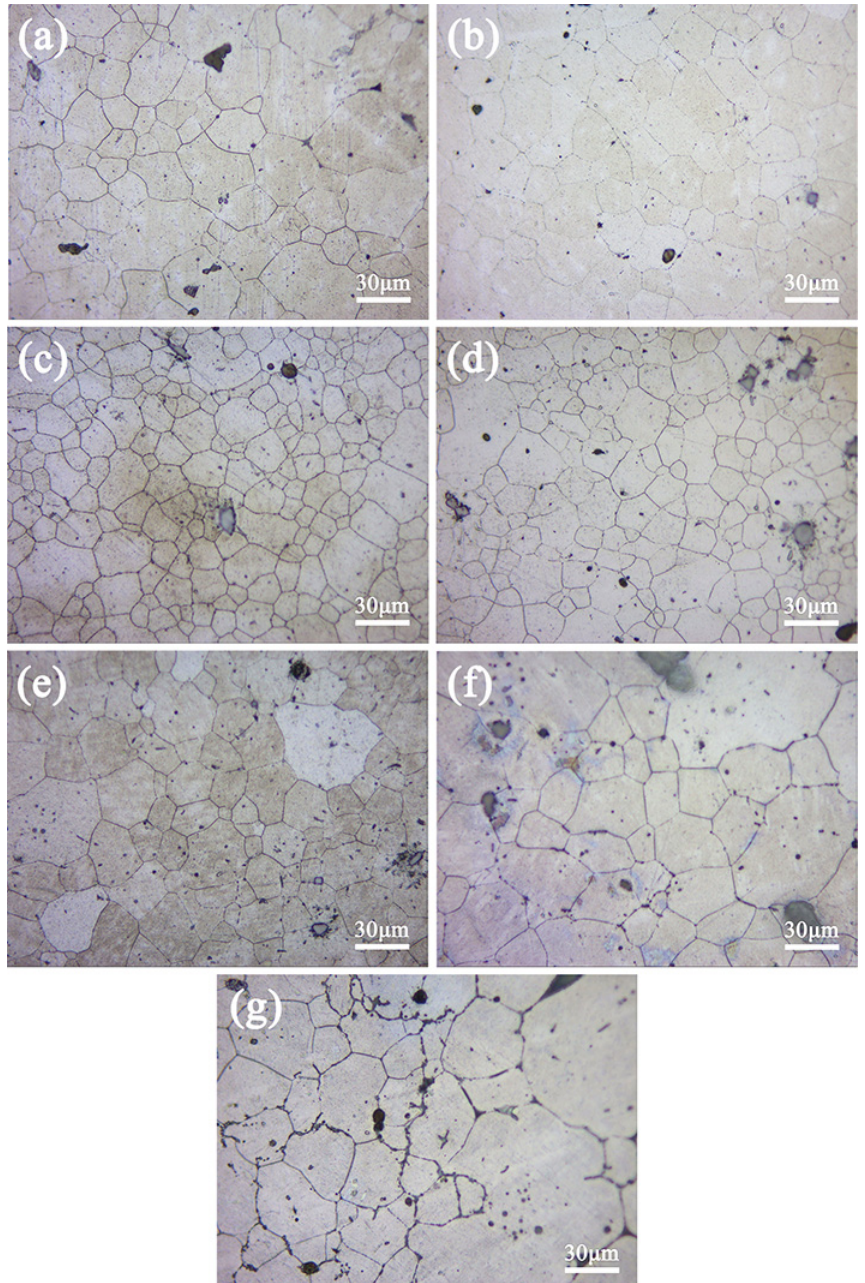
Figure 3. Optical micrographs of the double-aged ZTM641-xAl alloys, ( a ) x = 0, ( b ) x = 0.2, ( c ) x = 0.5, ( d ) x = 1, ( e ) x = 2, ( f ) x = 3 and ( g ) x = 4.